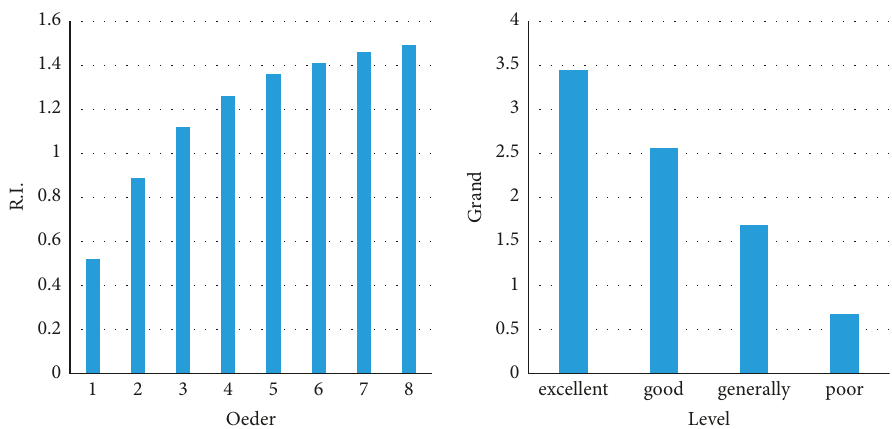
Figure 10: Comprehensive evaluation of innovation and entrepreneurship